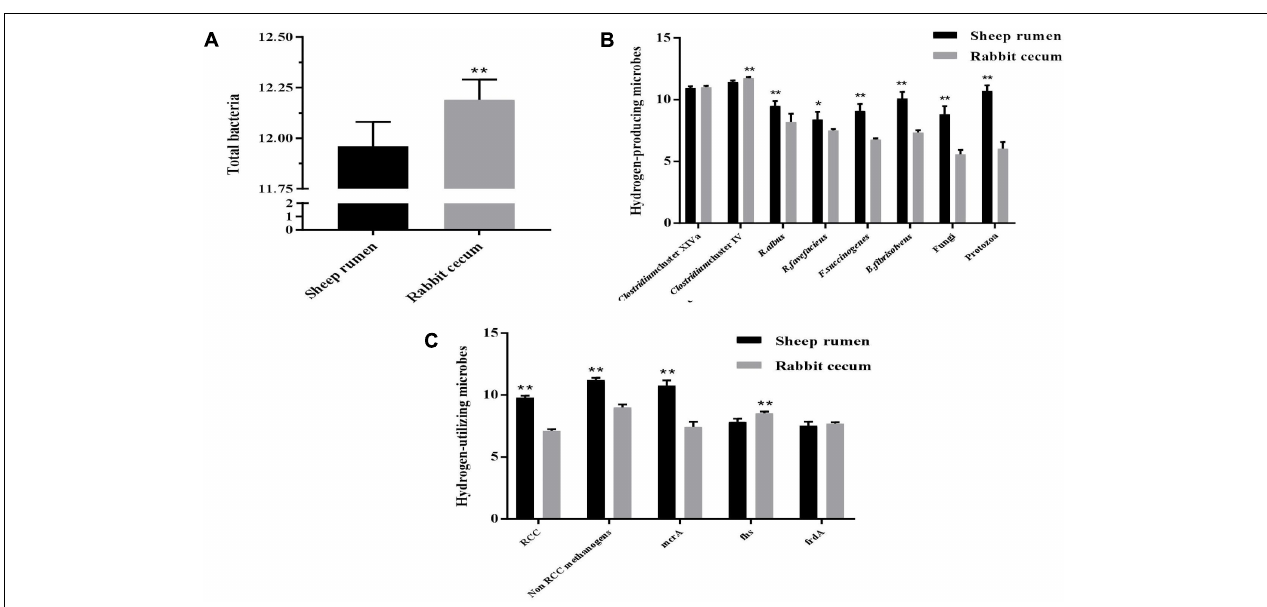
FIGURE 2 | Abundance of select microbes in the sheep rumen ( n = 5) and the rabbit cecum ( n = 15). (A) Total bacteria; (B) Select hydrogen-producing microbes; (C) Select hydrogen-utilizing microbes. Abundance was expressed as log10 copies of target gene/g freeze-dried digesta sample. Target gene: 16S rRNA gene